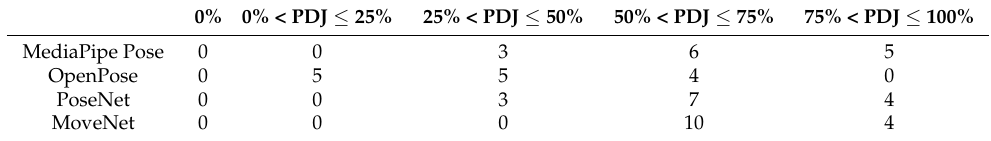
Table 5. Number of actions recognized by each HPE library in each specific range of PDJ